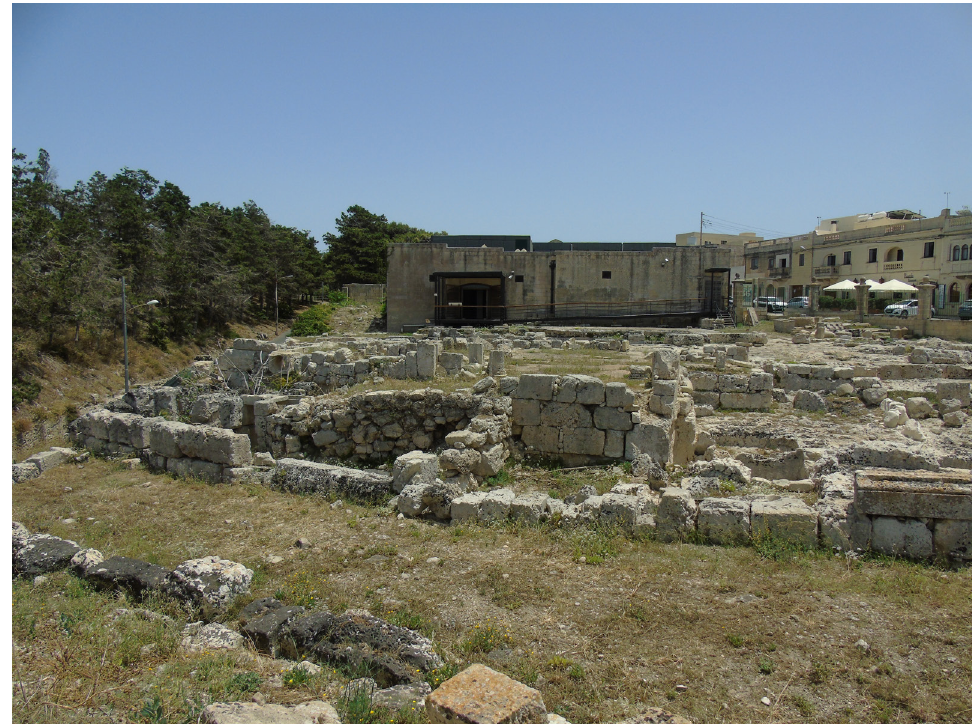
Figure 8: Housing to the north-west of the Domus Romana (Photo: author, courtesy of Heritage